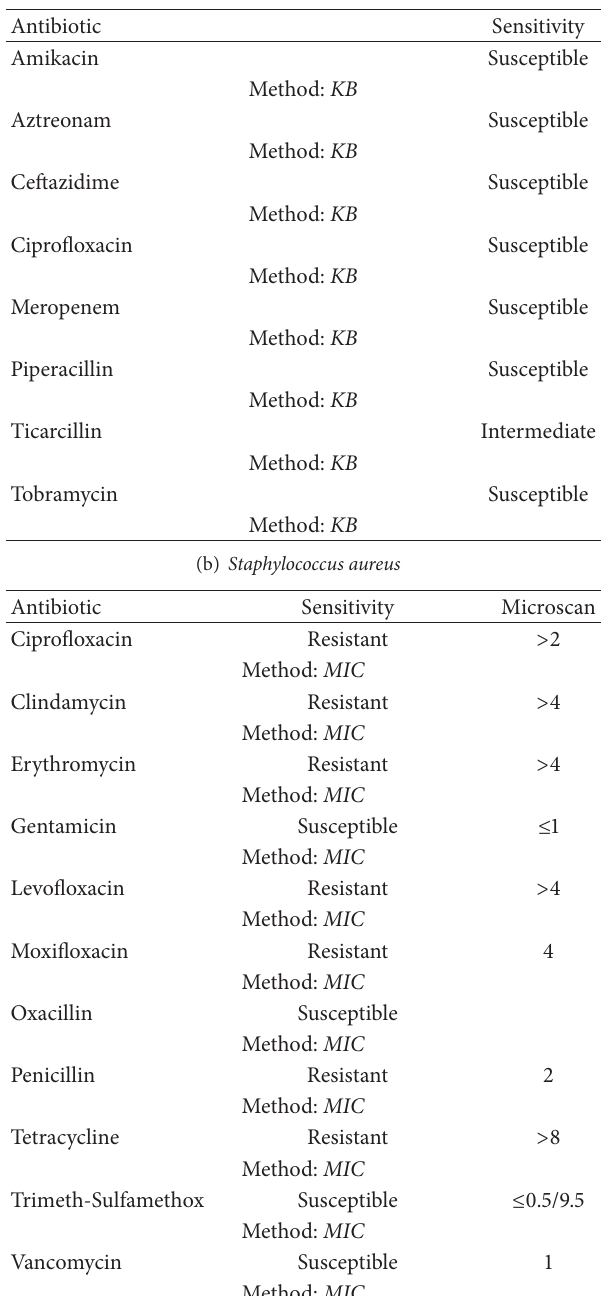
Table 1: Antimicrobial susceptibility charts for Pseudomonas aerug- inosa and Staphylococcus aureus from previous hospitalization.